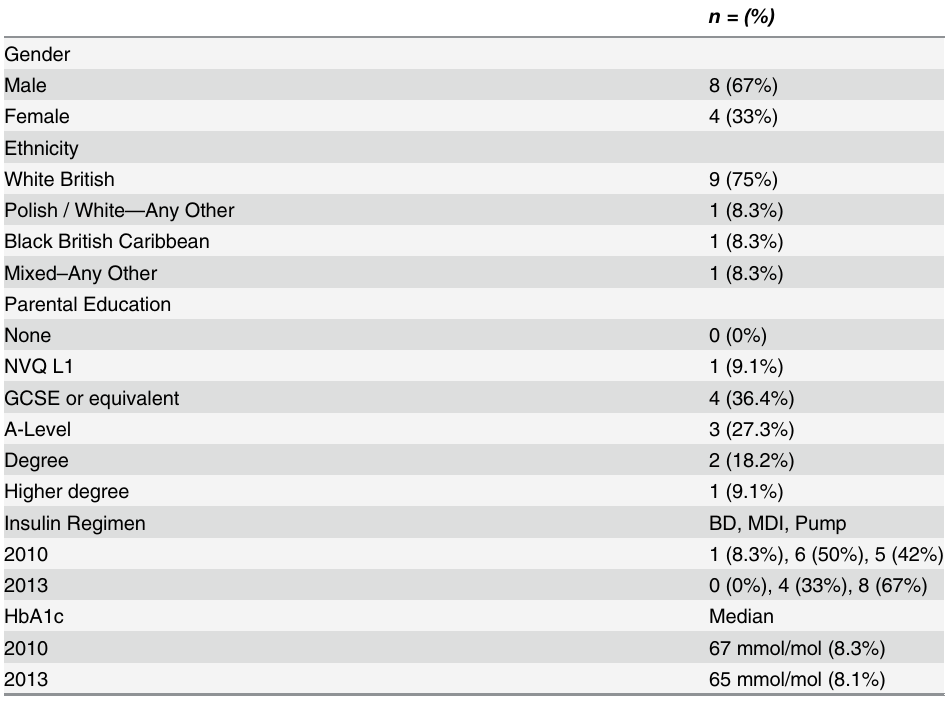
Table 1. Specific descriptive data in focus group participants (n =